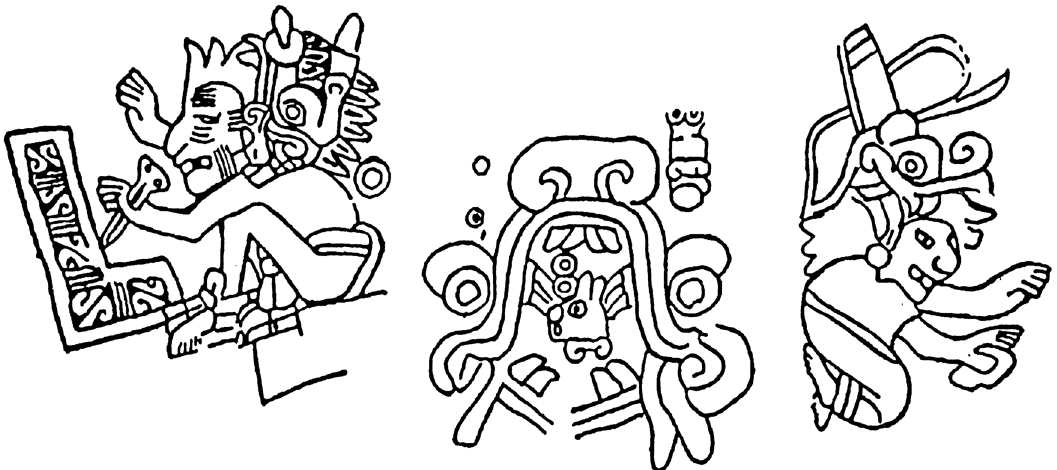
Figure 14: Aztec style carvings known as the “ Piedras de Coatlán, ” from the survey area. Drawing modi fi ed after Anders and Jansen ( 1988, p. 112 )